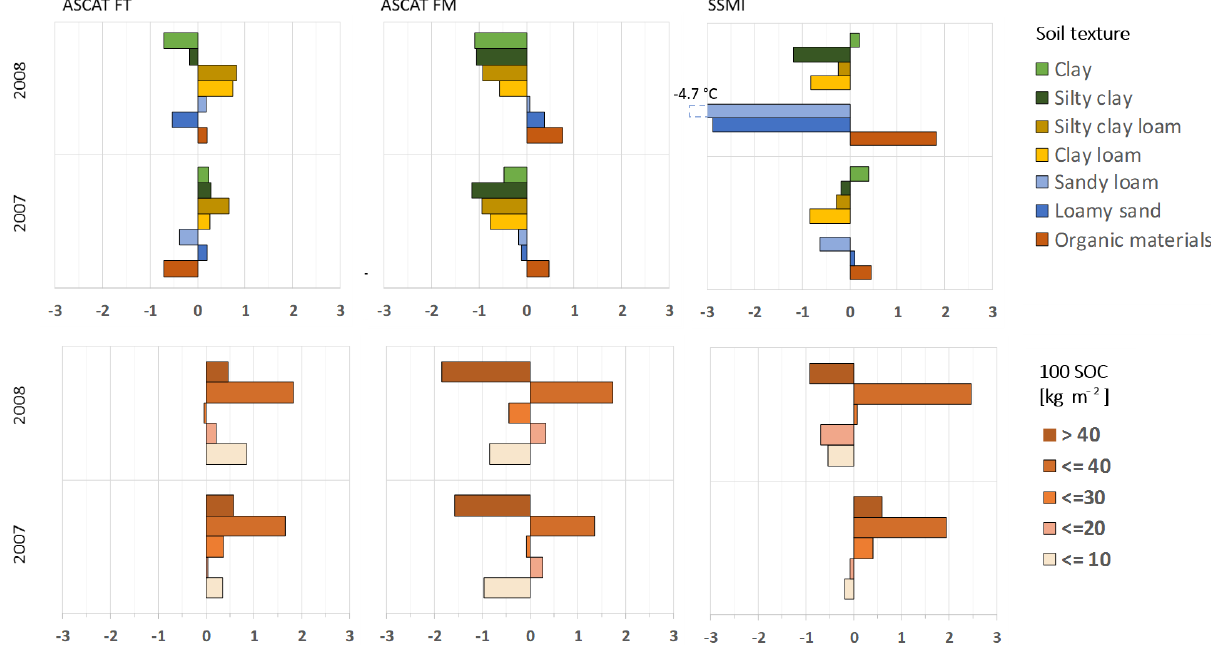
Figure 12. Difference between modelled MAGT c and in situ MAGT c (coldest sensor) by soil texture (source is Fischer et al., 2008) and soil organic carbon content within the top 100cm (100SOC; source is Hugelius et al., 2013, 2014) in 2007/2008 and 2008/2009. FT – days identified as frozen without melting snow are used; FM – days with melting snow are considered to be frozen ground in ASCAT.